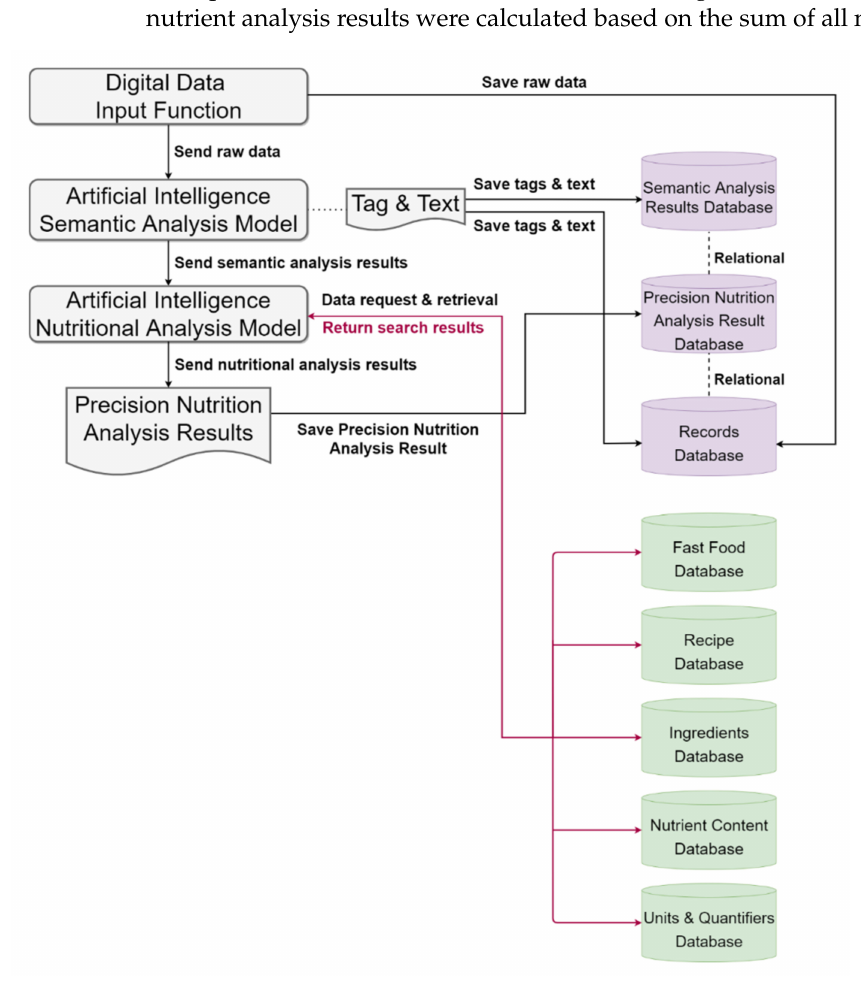
Figure 3. Model Operating